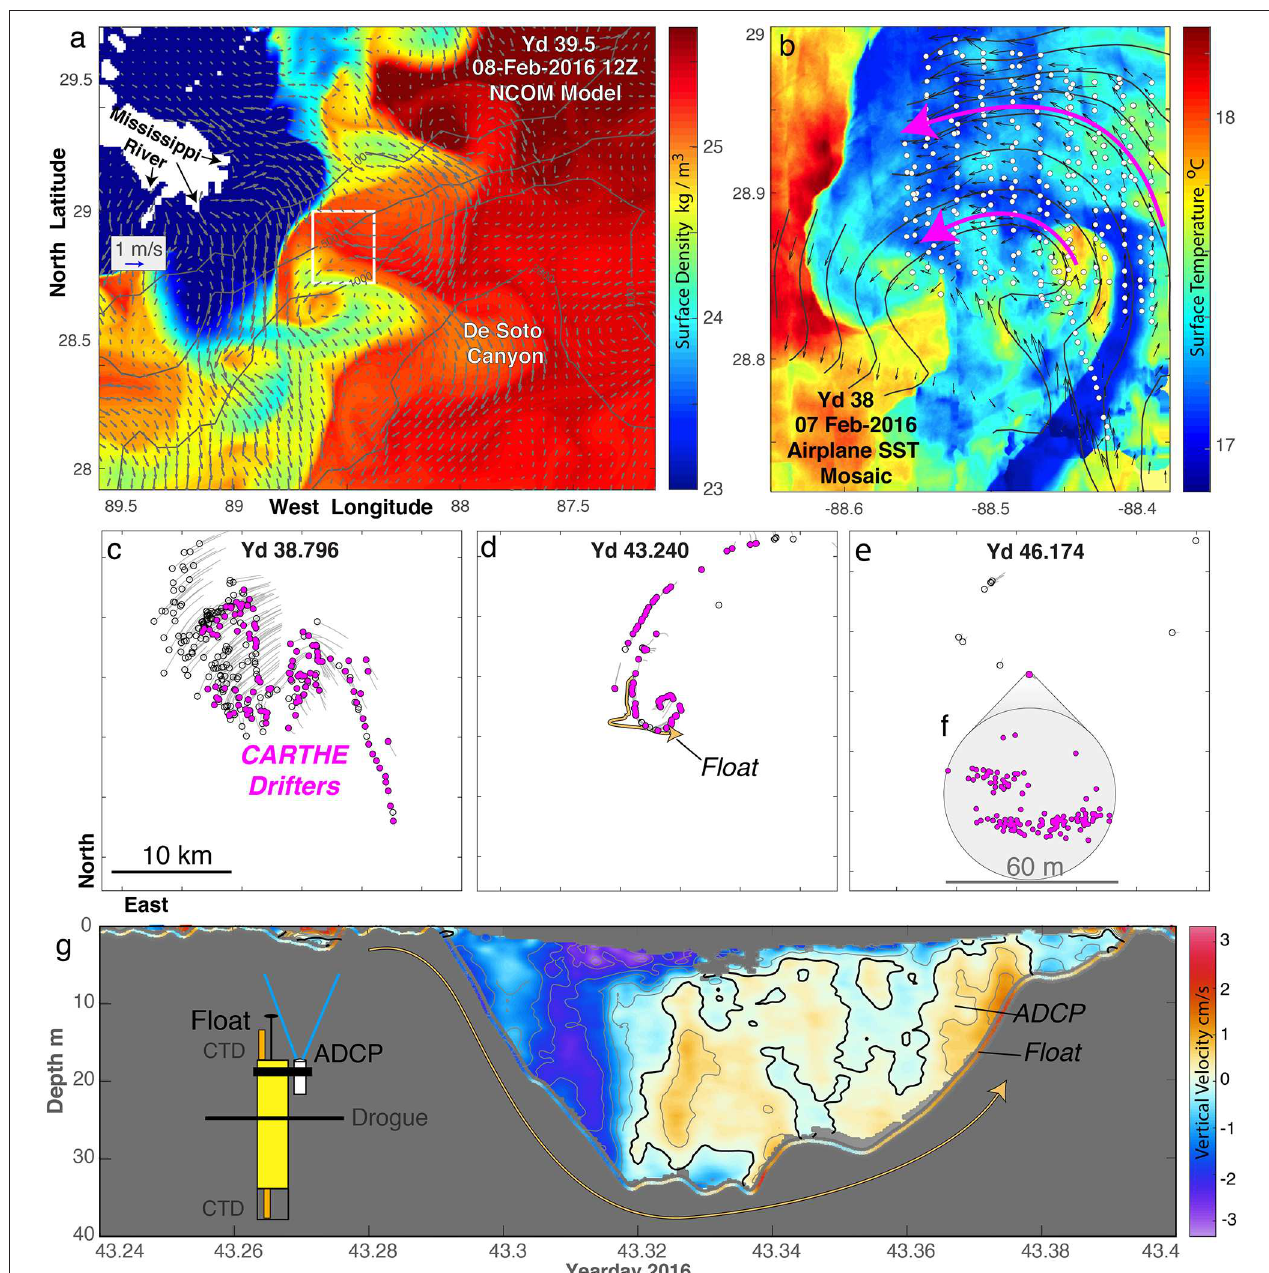
FIGURE 8 | Clustering and vertical velocity at a submesoscale front measured during the CARTHE LASER experiment (D’Asaro et al., 2018). (a) Surface density (colors) in the experimental region as simulated by the Navy Coastal Ocean Model (NCOM). Surface velocity (vectors) and bottom depth (gray lines) are shown. (b) Aircraft survey of SST (colors) located by the white box in (a) . White dots show deployment locations of surface drifters. Black vectors indicate 7 m velocity measured by the ship, black lines show streamfunction, and Magenta arrows show sense of circulation. (c–f) Evolution of the drifter array over the next 8 days with gray lines showing 7,500-s-long “tails” of drifter motion. Magenta drifters converge into a 60-m-wide cluster of 127 drifters shown in (f) . (g) Vertical trajectory of a neutrally buoyant Lagrangian float (sketched in figure) carrying an upward looking acoustic Doppler velocity profiler (ADCP). The yellow line in d) shows the approximate float trajectory. Colors show vertical velocity measured by the float’s motion (thin band) and by the ADCP (colored region). The float descended from the surface to about 35 m and then returned to the surface. The average descent speed measured from pressure was about 0.013 ± 0.001 ms − 1 ; the ADCP agreed, measuring 0.013 ± 0.001 ms − 1